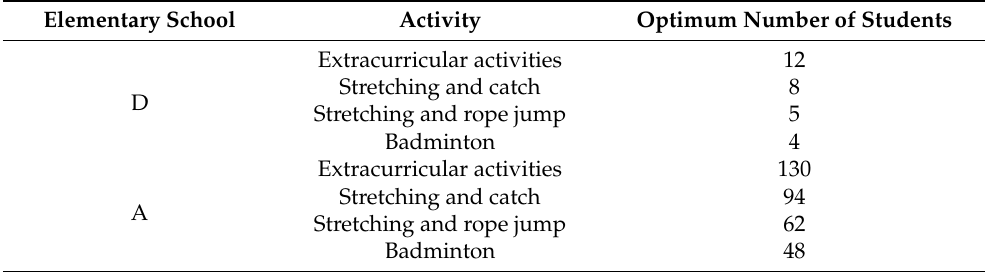
Table 13. Optimum number of students according to activities for D and A Elementary